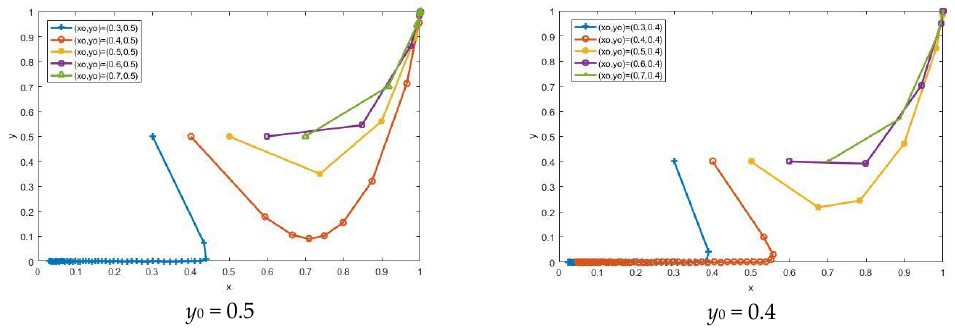
Figure 3. The impact of changes in x 0 on the evolutionary result.